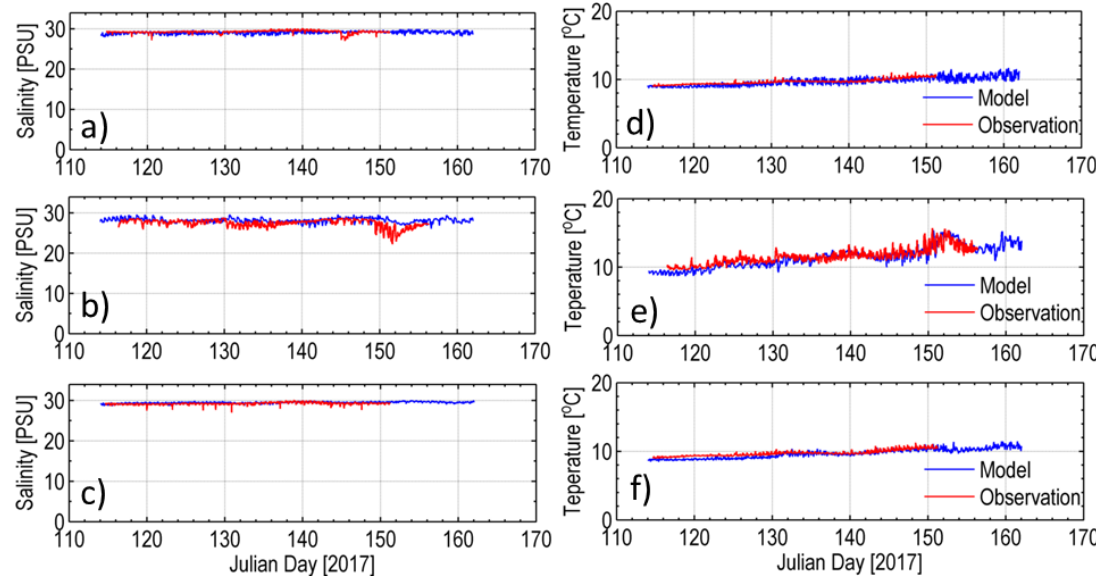
Figure 7. Time series of model results and observed data for salinity (left panel) and temperature (right panel) from 31 May and 1 June 2017. Plots ( a , d ) are a comparison for the North acoustic Doppler current profiler (ADCP) station; plots ( b , e ) are for the Bridge ADCP station; and plots ( c , f ) are for the South ADCP station. Table 2. Salish Sea model calibration error statistics and skill score for water elevation. AME = absolute mean error. AME RMSE 0.960